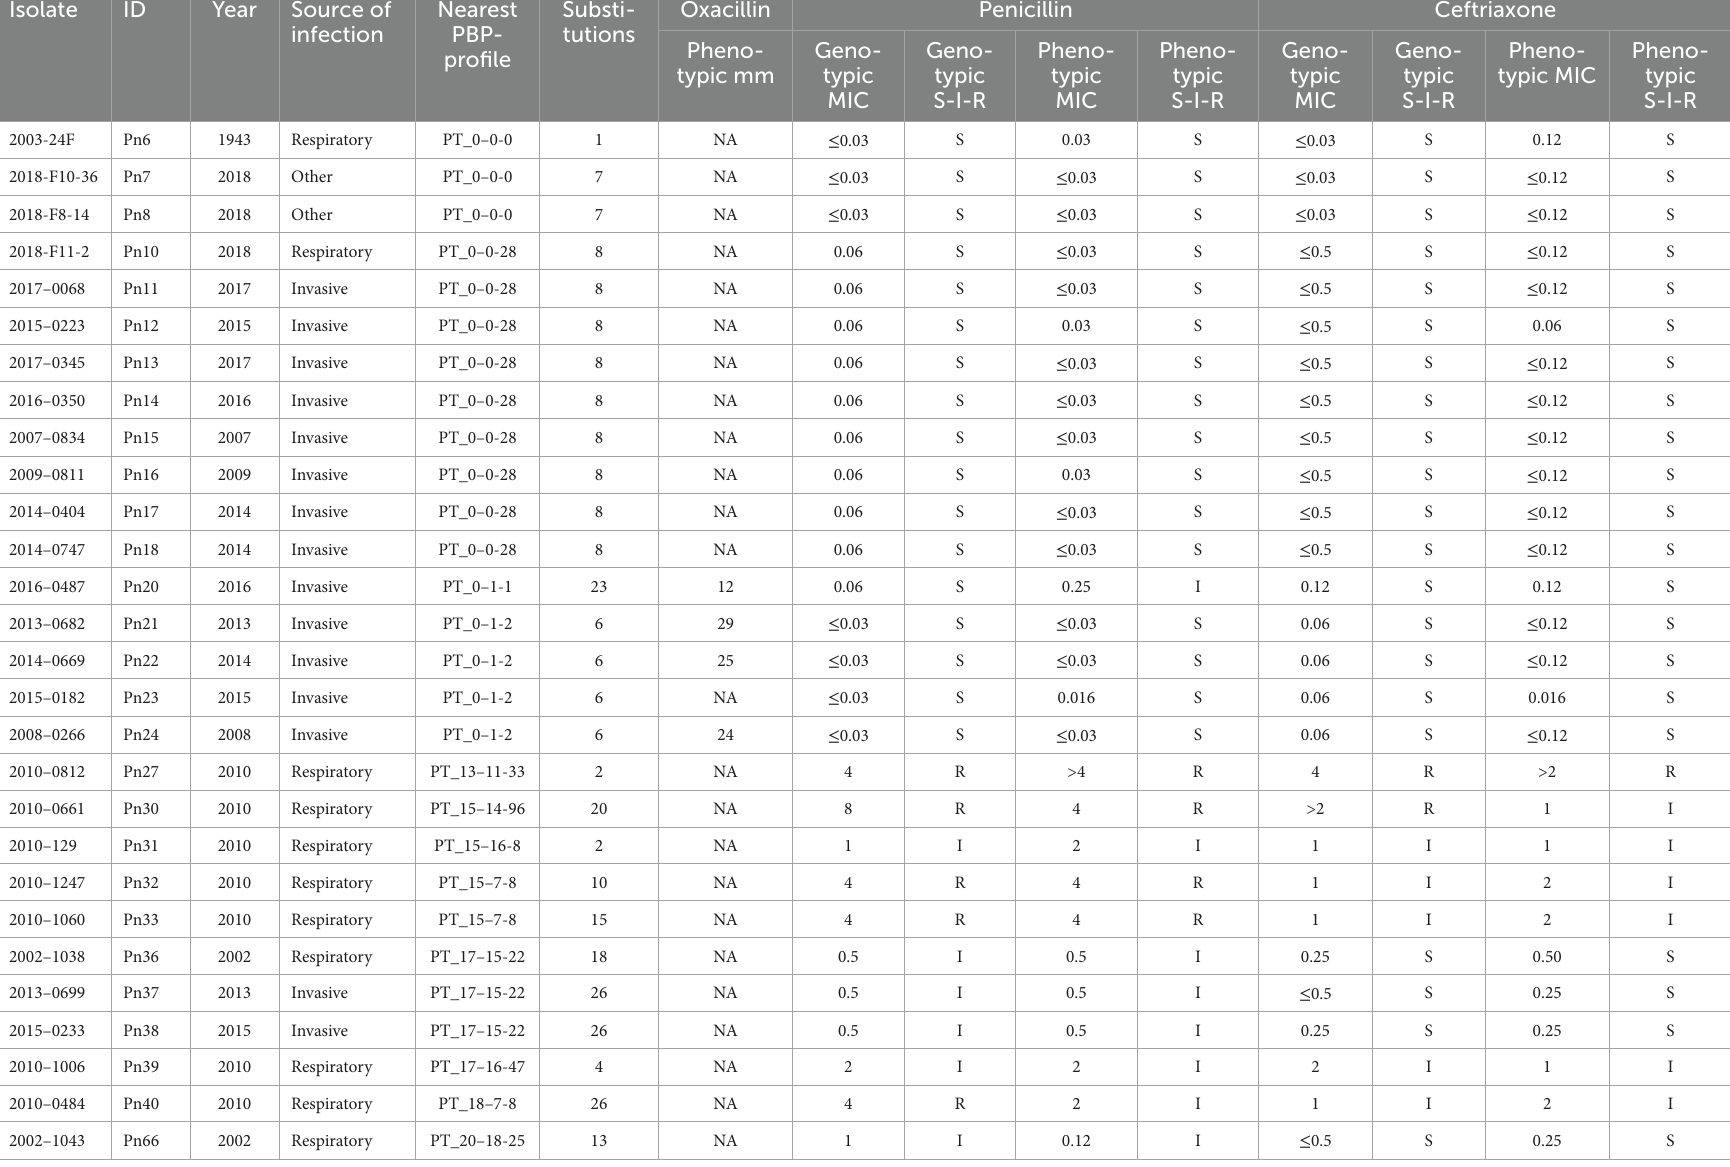
TABLE 4 Genotypic and phenotypic susceptibility in Streptococcus pneumoniae isolates with a new PBP-profile.